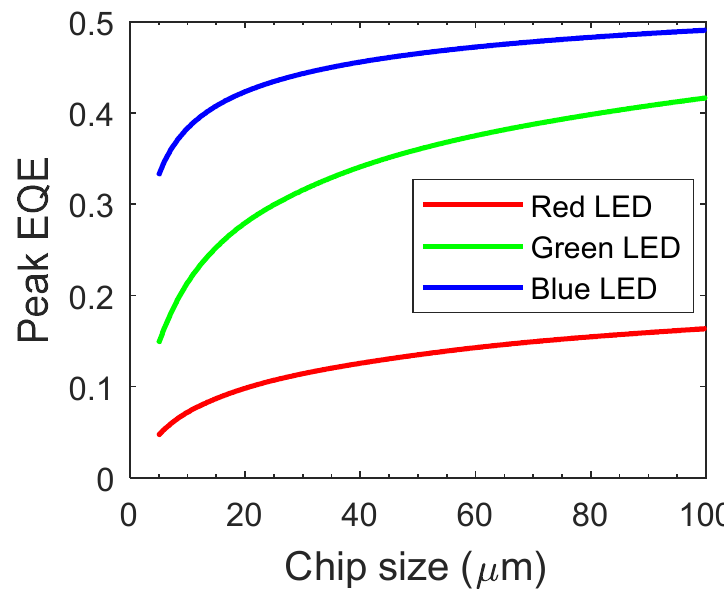
Figure 4. The peak EQE of RGB micro-LED as a function of LED chip size.